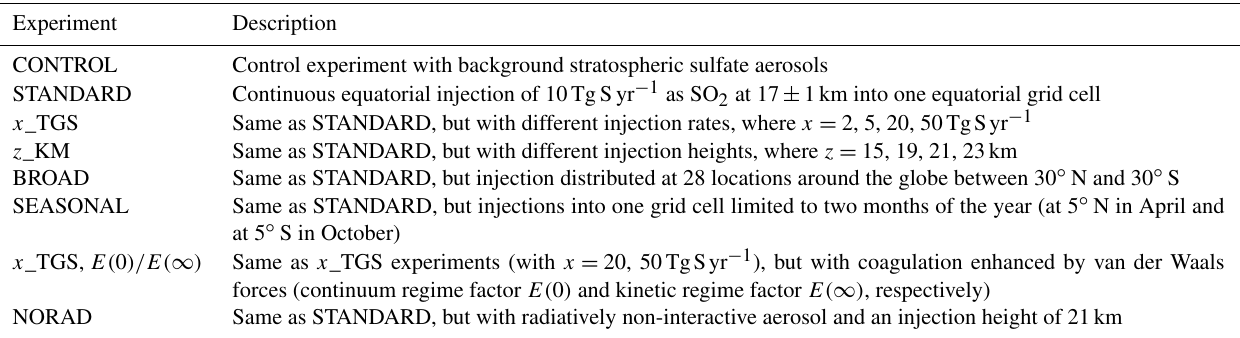
Table 1. Description of the experiments performed in this study. Experiment Description